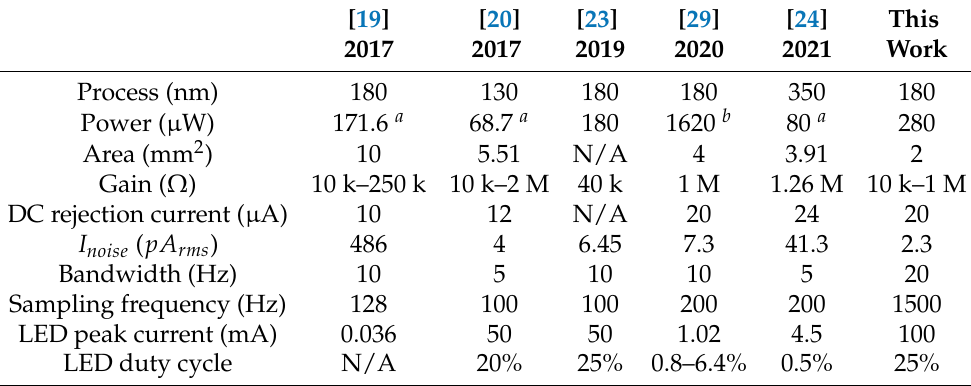
Table 1. Comparison with other state-of-the-art